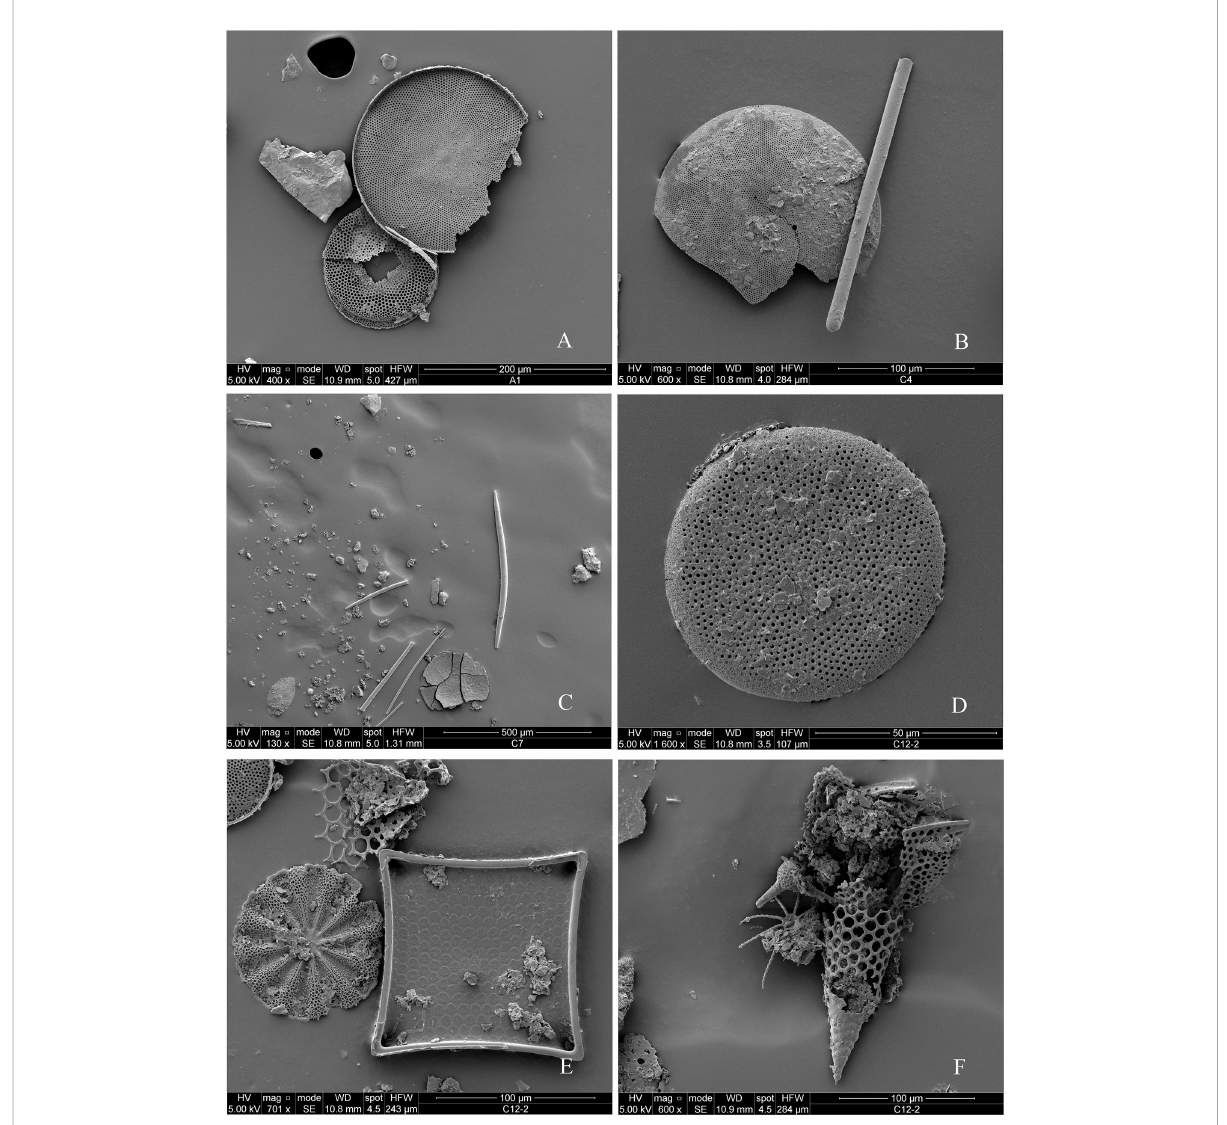
FIGURE 7 SEM images show different siliceous organisms found in sediment samples (A1, C4, C7, and C12) before alkaline digestion. (A) diatom frustule in sample A1, (B) diatom frustule and sponge spicule in sample C4, (C) diatom frustule and sponge spicule in sample C7, (D-F) diatom frustules and radiolarian skeletons in sample C12. Sample A1 was pretreated using HCl (1.0 M) and H 2 O 2 (10%) for 1 h, sample C4, C7, and C12 were not